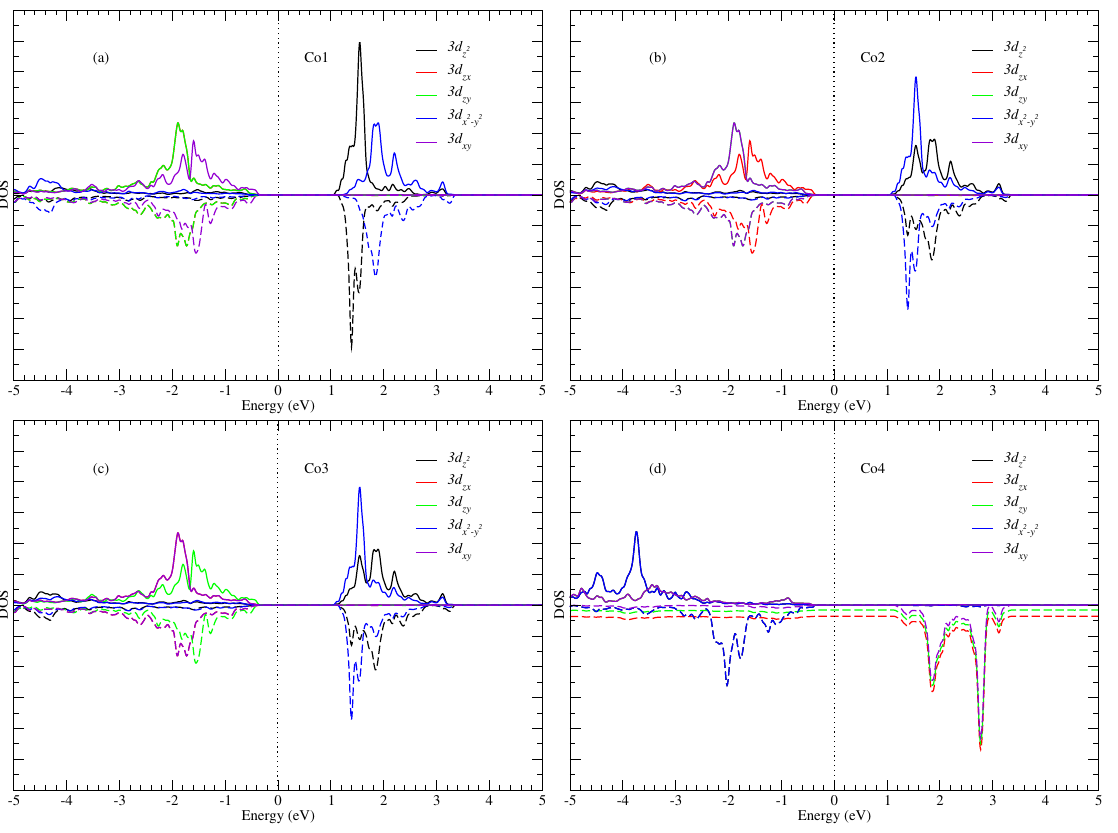
Figure 5. Partial DOS, for the 3 d orbitals of the nearest cobalt atoms Co1 ( a ), Co2 ( b ), Co3 ( c ) and Co4 ( d ) to the oxygen absorbing atoms. Solid and dashed lines correspond to spin-up and spin-down DOS components respectively. The peaks located in the energy range between 0 and 3.4 eV are responsible for the pre-edge peak in the O K -edge spectrum between 530 and 534 eV (Figure 3).